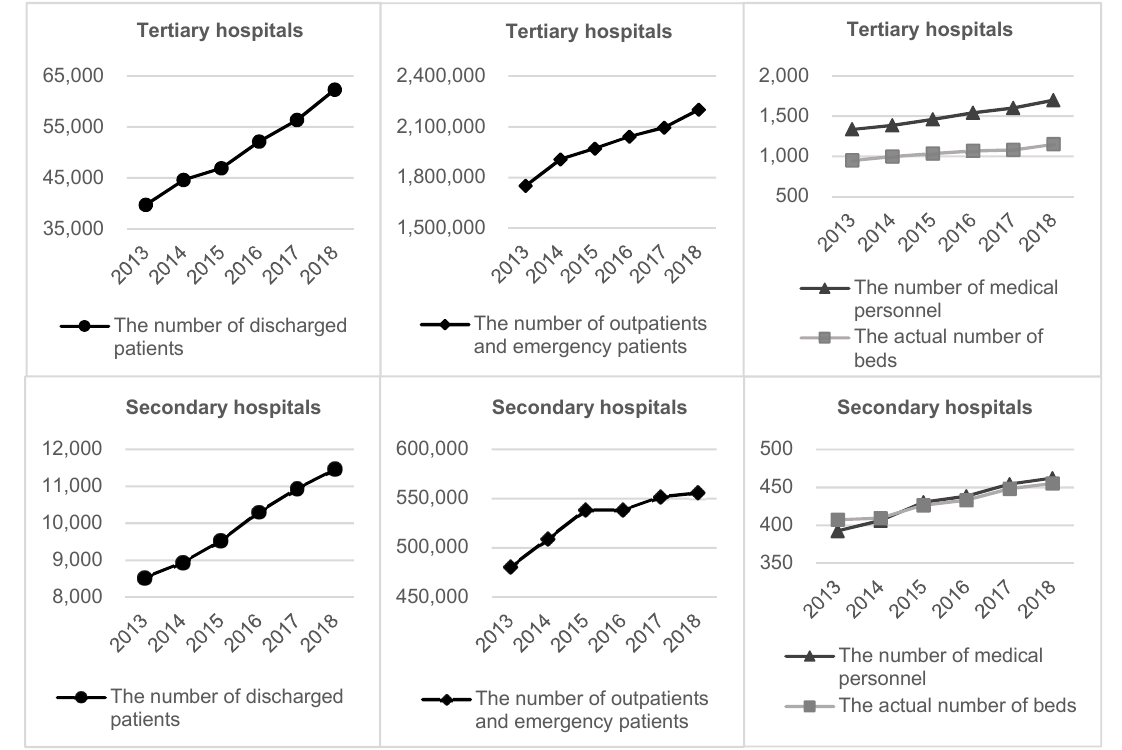
Figure 1. The average operation scales of tertiary and secondary hospitals (2013–2018).